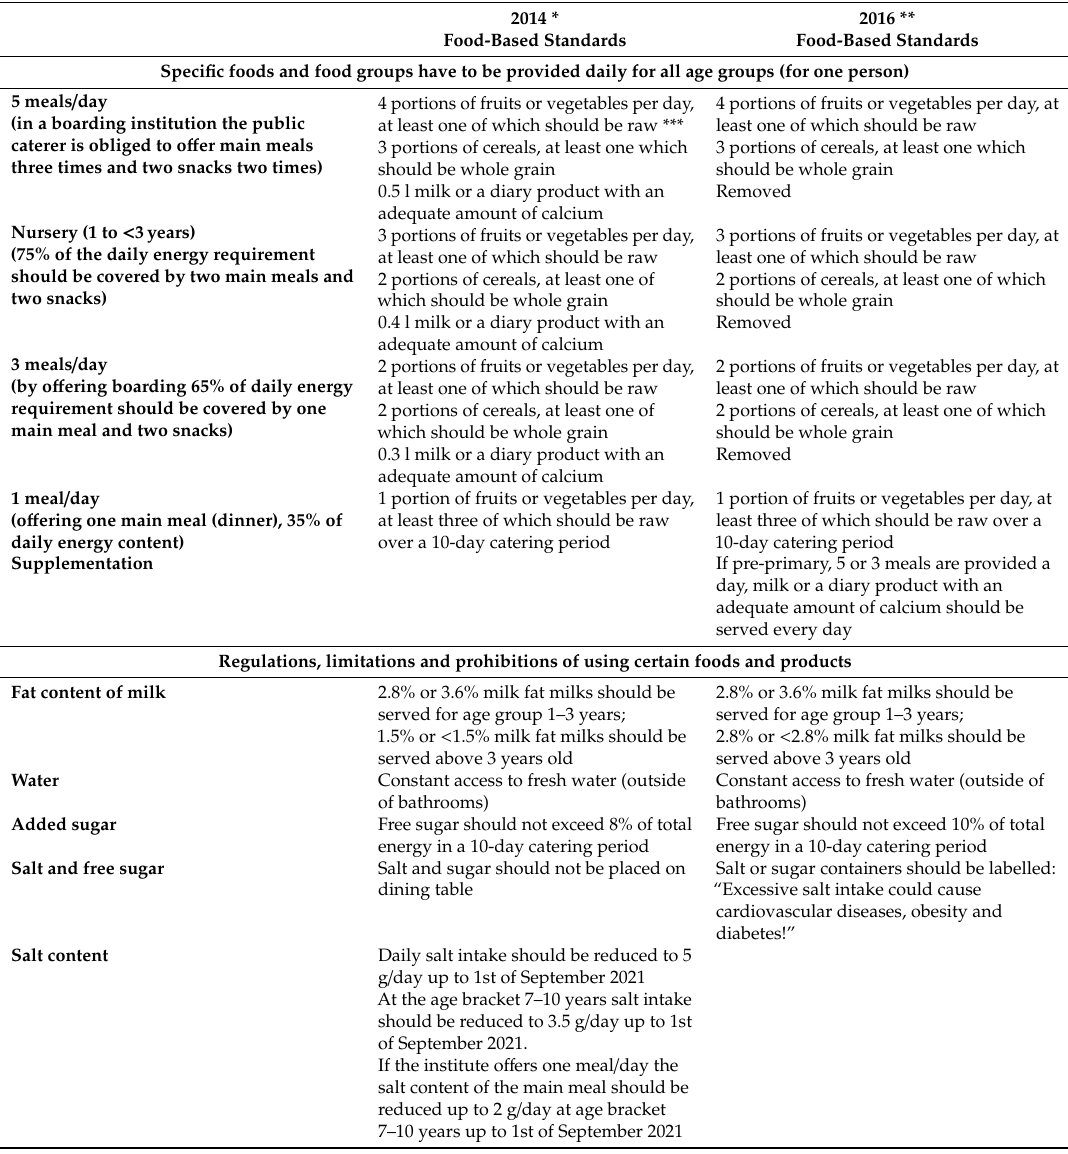
Table 3. The most important changes in the public catering